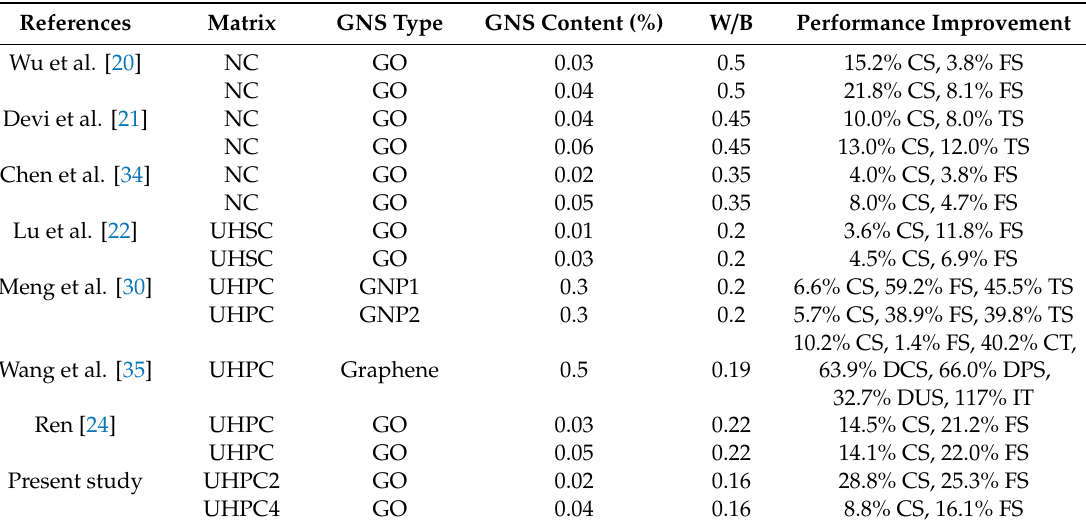
Table 4. Comparison of physical properties